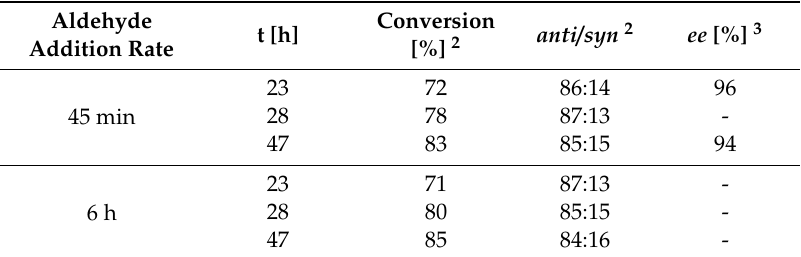
Table 6. Process scale-up study 1 .